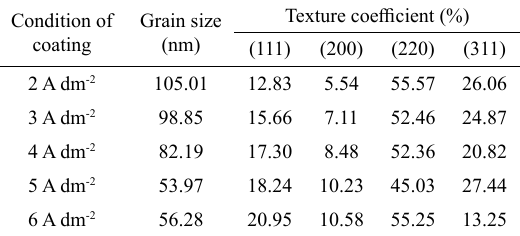
Table 3. Effect of current density on grain size and texture coefficient.